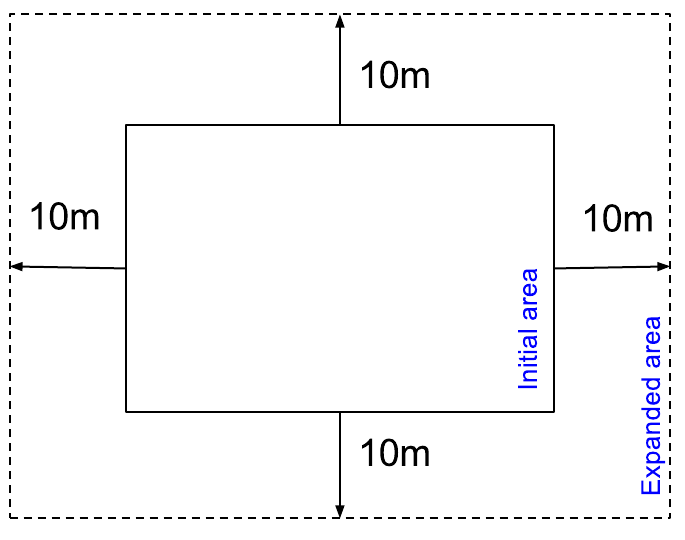
Figure 6. Area expansion to contemplate the proximity of points in adjacent areas. Source: the authors.